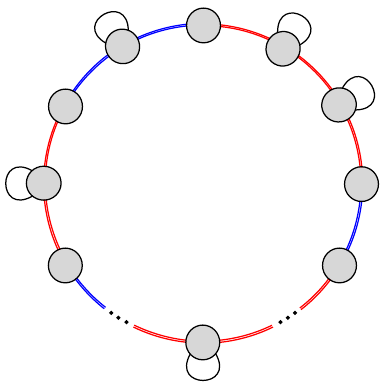
Figure 6 . A Necklace quiver composed of N = 1 and N = 2 vector multiplets connected by hy-